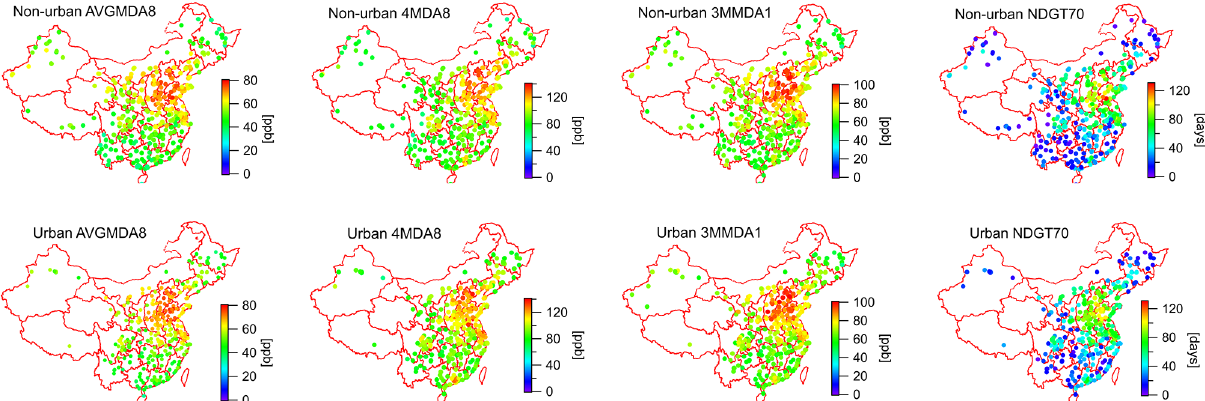
Figure 1. Spatial distribution of four ozone (O 3 ) metrics (AVGMDA8, 4MDA8, 3MMDA1, NDGT70) at urban and non-urban sites averaged over 2014–2020. The AVGMDA8 is the mean MDA8 O 3 in the warm season (April–September); other metrics are annual